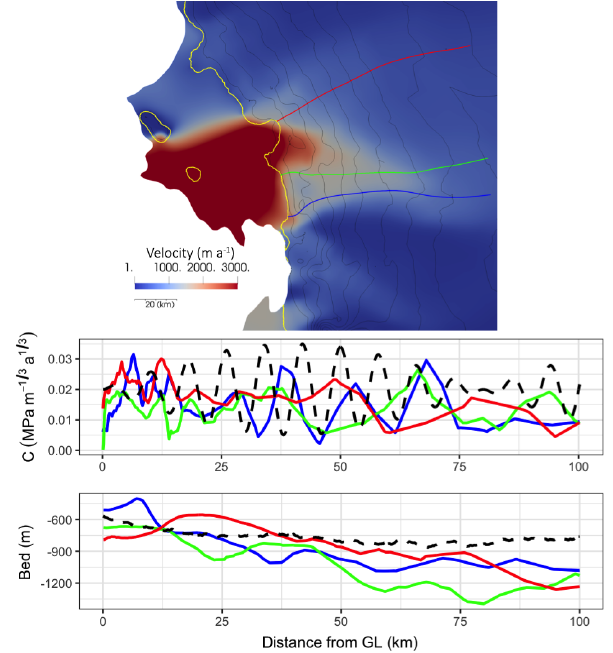
Figure 4. Thwaites Glacier (Antarctica). Model results from Bron- dex et al. (2019): model velocities (top) and friction coefficient C and bed elevation b extracted along three streamlines (same colour code). Synthetic values used in this study are shown with black dashed lines. Note that the mesh resolution varies from (cid:118) 200m close to the GL, shown in yellow in the top panel, to (cid:118) 10km at the upstream end of the